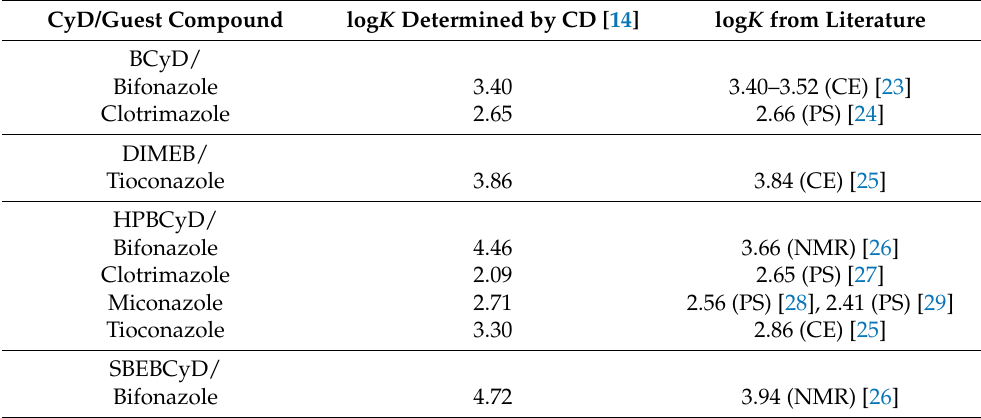
Table 1. Comparison of stability constants. Abbreviations: CE—capillary electrophoresis; PS—phase solubility measurement, NMR— 1 H nuclear magnetic resonance spectroscopy. CyD/Guest Compound log K Determined by CD [14] log K from